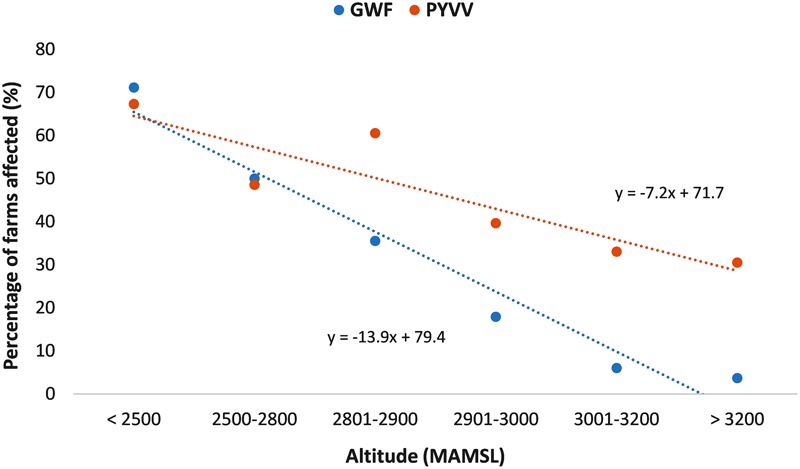
Association between altitude and the percentage of farms affected by the greenhouse whitefly (GWF; blue dots) and the potato yellow vein virus (PYVV; orange dots).